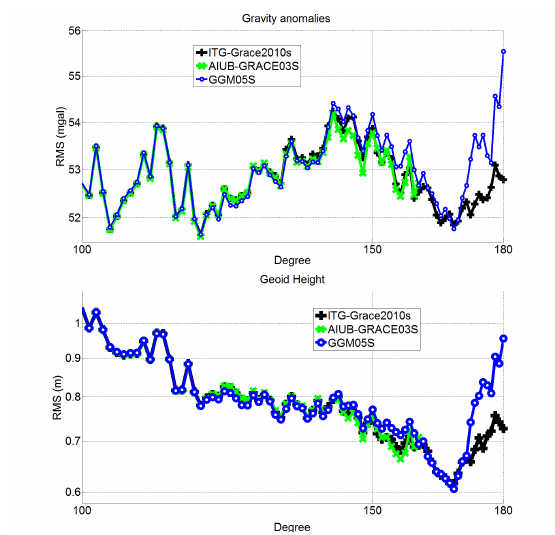
Figure 8: RMS variations in gravity anomaly and geoid height that have been obtained from comparison between terrestrial data and computed values based on GRACE-only extracted gravity models. RMS differences are captured over the degree 150 while significant deterioration of the residuals are revealed over a threshold at de- gree 167.